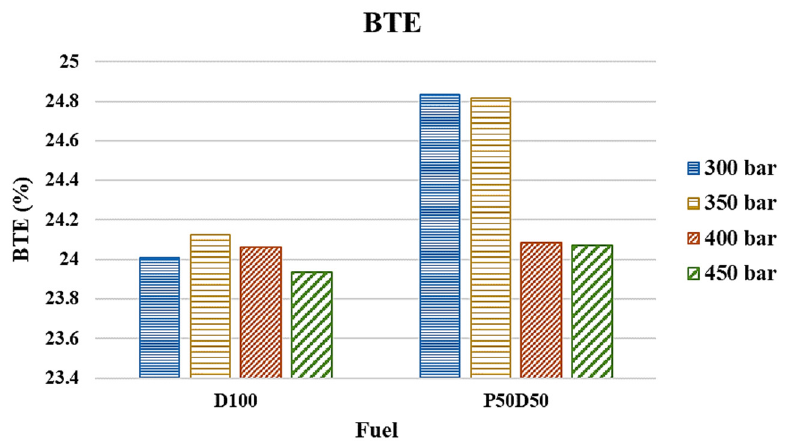
Figure 5. BTE under various injection pressures.